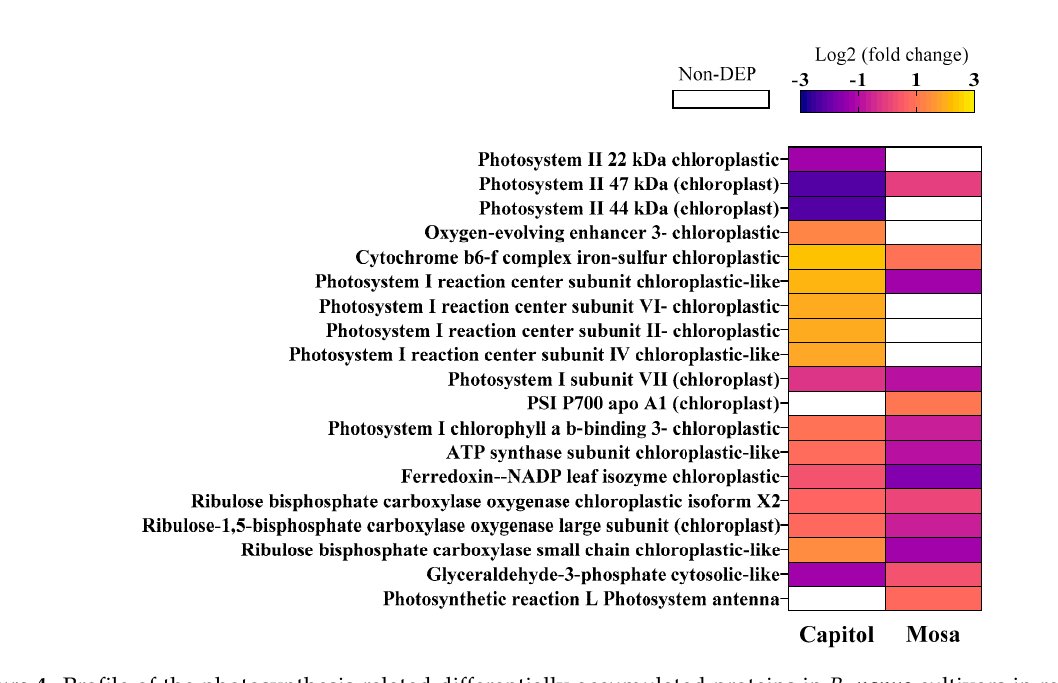
Figure 4. Profile of the photosynthesis-related differentially accumulated proteins in B. napus cultivars in responses to Xanthomonas campestris pv. campestris (Xcc). Significantly expressed proteins (fold changes of ≥ 1.5 and ≤ 0.5 with p < 0.05, upregulated and downregulated, respectively) are presented as Log2 fold changes (Xcc/Non-Xcc). DEP—differentially expressed protein.